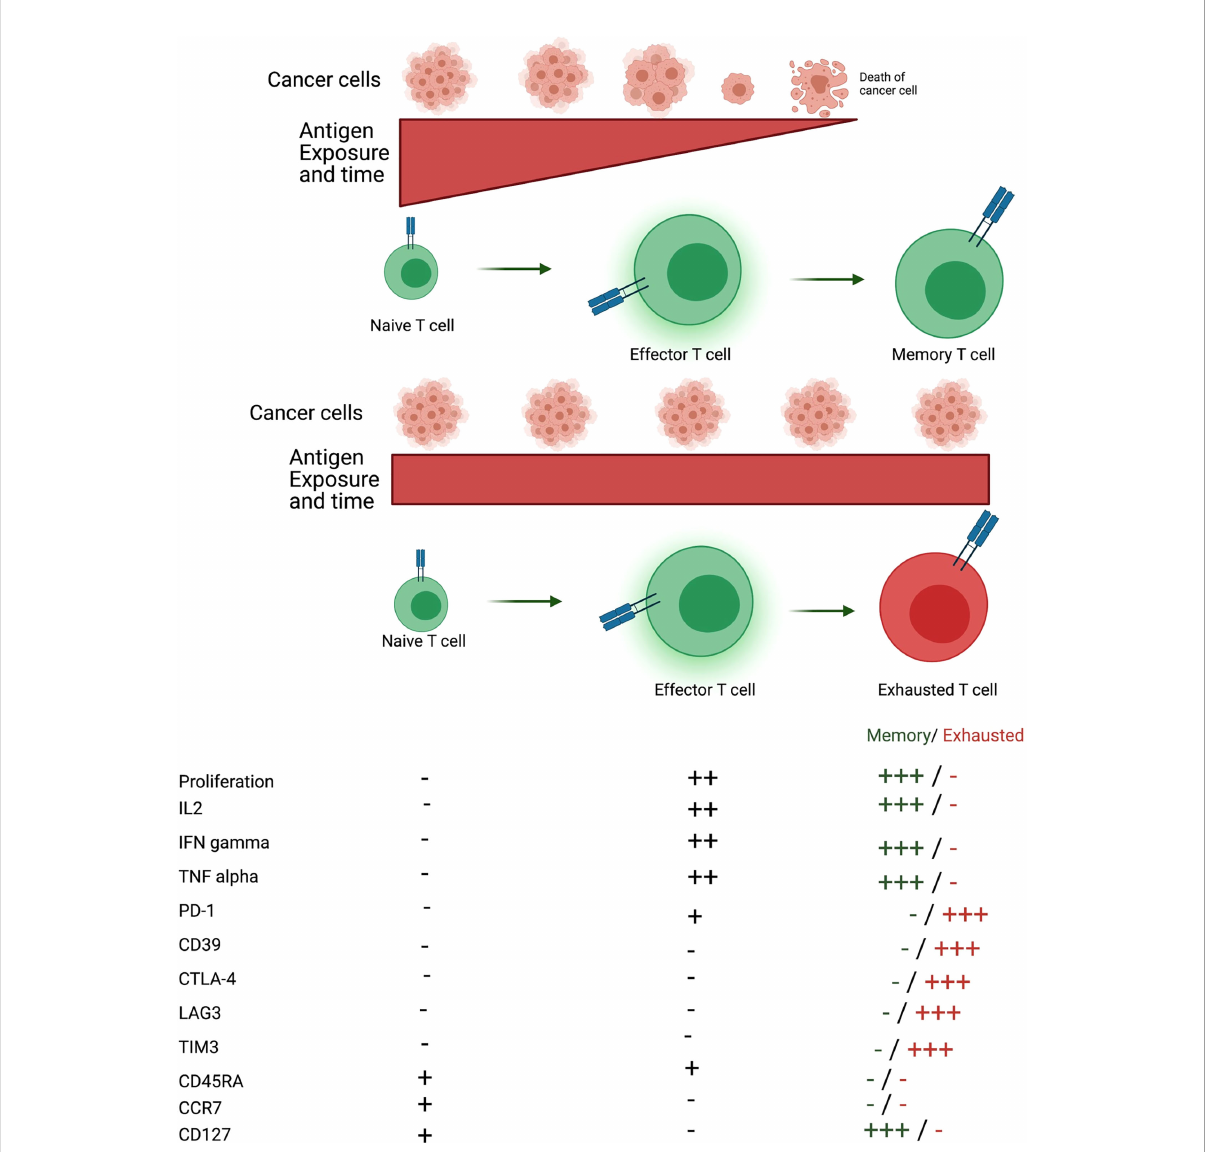
FIGURE 2 Formation of memory and exhausted T cells. After antigen encounter naïve T cells differentiate into effector T cells that are proliferative and exert their function through secretion of several cytokines such as IL-2, IFN-gamma and TNF-alpha. If the antigen is eliminated, T cells differentiate into memory T cells, which can proliferate and secrete cytokines quickly when reencountering the antigen. On the other hand, if the antigen persists effector T cells differentiate into a state called T cell exhaustion. Exhausted T cells are non-proliferative, not functional and express several inhibitory molecules such as PD-1, CD39, CTLA-4, LAG3 and TIM3. Memory T cells do not express CD45RA and CCR7. There are distinct memory T cell populations, such as effector memory and central memory but effector memory is the population described. Figure generated using Biorender